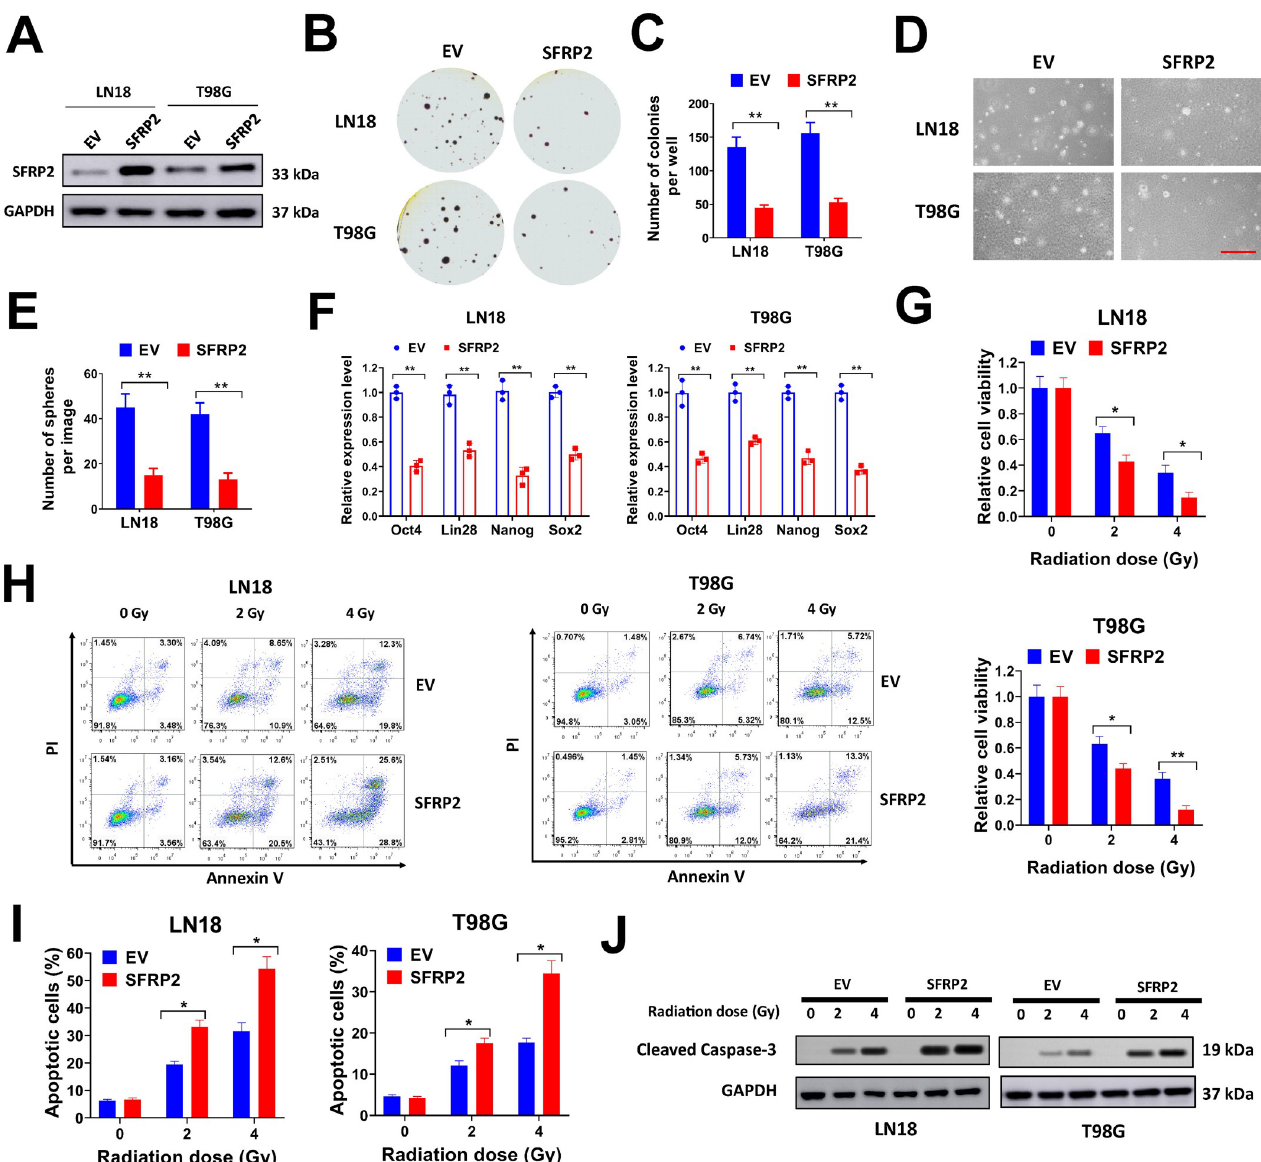
Fig 3. Forced SFRP2 expression suppresses soft agar colony formation, cancer stemness and radioresistance of glioma cells. A, LN18 and T98G cells were infected with SFRP2 expression lentivirus or empty vector (EV) control, then protein expression of SFRP2 was evaluated by western blot. B-C, LN18 and T98G cells were infected with SFRP2 expression lentivirus or EV control, then seeded in 6-well plates at 8000/well for soft agar assay. Representative plates (B) and average number of colonies per well (C) were shown. D-E, LN18 and T98G cells were infected with SFRP2 expression lentivirus or EV control, then seeded in 6-well plates at 3000/well for sphere formation assay. Representative images (D) and average number of spheres per image (E) were shown. F, expression of Oct4, Lin28, Nanog and Sox2 in LN18 and T98G cells infected with SFRP2 expression lentivirus or EV control was evaluated by qRT-PCR. G, LN18 and T98G cells were infected with SFRP2 expression lentivirus or EV control, then seeded in 96-well plates (3000/well) and treated with a single dose of 2 or 4 Gy X-ray irradiation. Cell viability was tested at 72 h after irradiation. H-J, LN18 and T98G cells infected with SFRP2 expression lentivirus or EV control were seeded in 6-well plates (1 × 10 6 /well) and treated with a single dose of 2 or 4 Gy X-ray irradiation. Then cells were used for flow cytometry (H-I) or western blot (J) at 24 h after the irradiation. Percentages of Annexin-V positive cells (I) were shown. � P < 0.05, �� P <